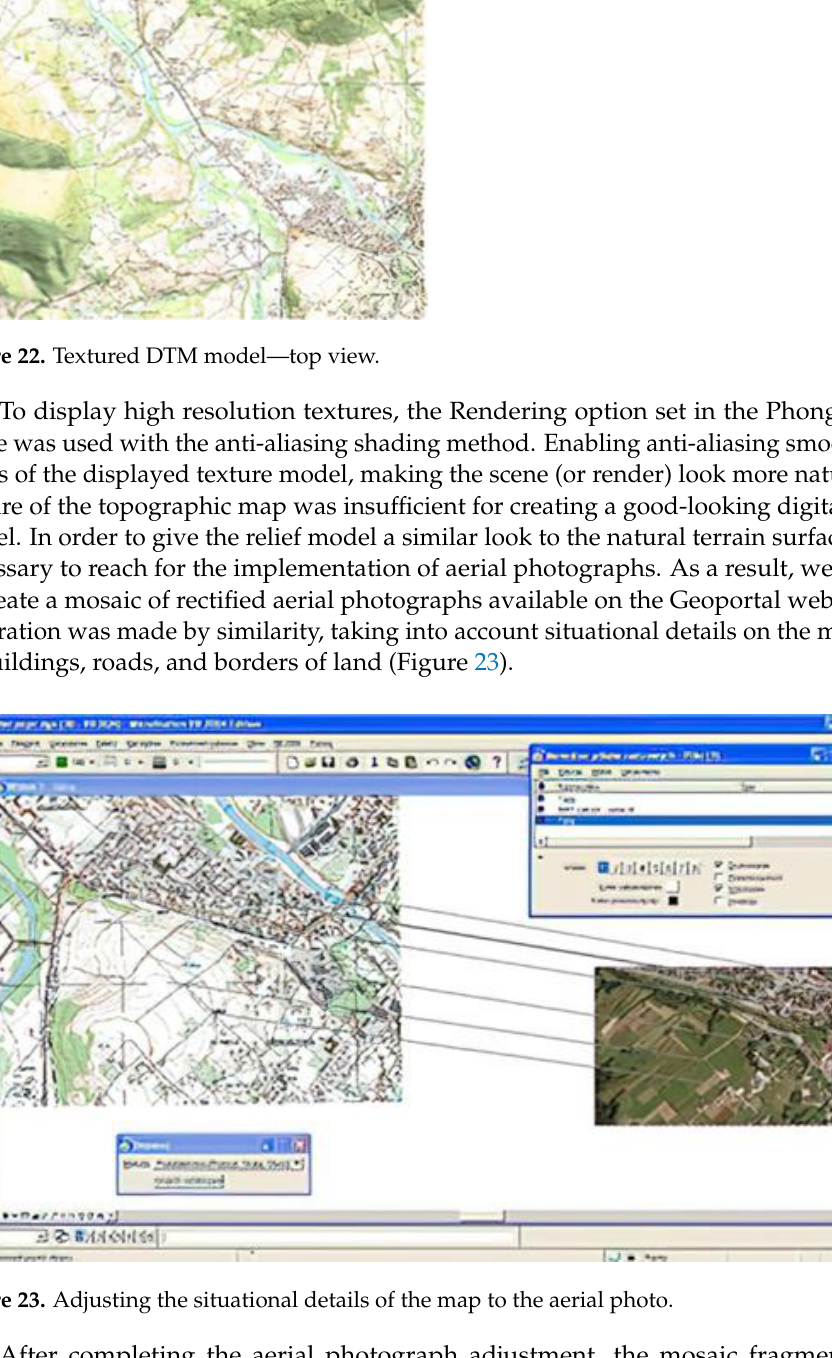
Figure 21. Textured DTM model — isometric view.